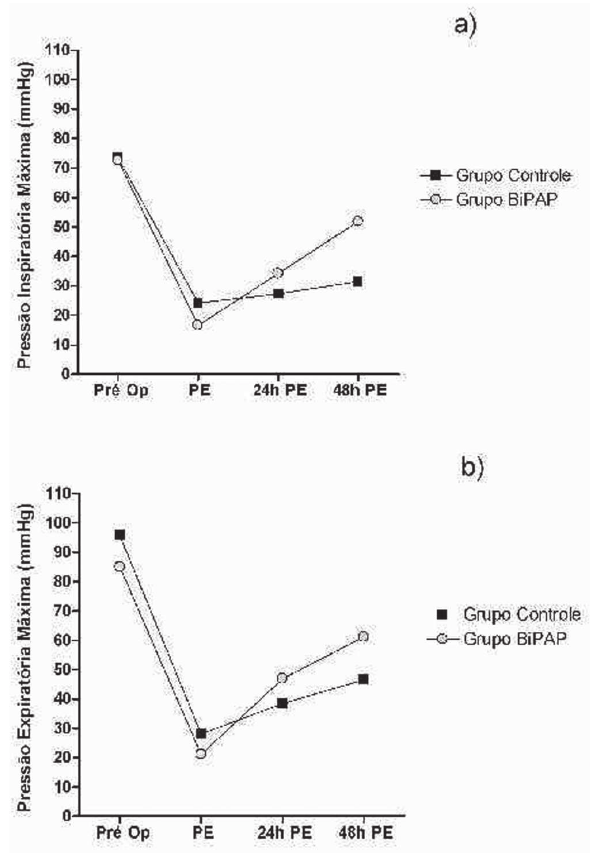
Fig. 4 – A: Distribuição representativa das alterações da Pressão Inspiratória Máxima no pré-operatório, pós-extubação imediata, 24 e 48 horas pós-extubação em média, nos grupos Controle e BiPAP. Pré-op= Pré-operatório e PE= Pós-extubação. (P<0,001 intragrupos; P=0,123 intergrupos); B: Distribuição representativa das alterações da Pressão Expiratória Máxima no pré-operatório, pós-extubação imediata, 24 e 48 horas pós-extubação em média, nos grupos Controle e BiPAP. Pré-op= Pré-operatório e PE= Pós- extubação. (P=0,540 intragrupos; P=0,056